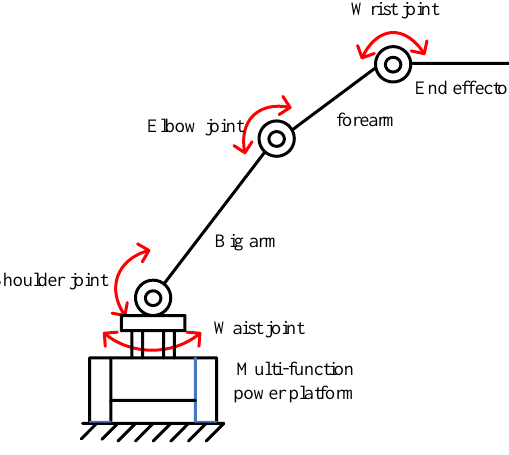
Figure 1. View of the pollen-picking manipulator.